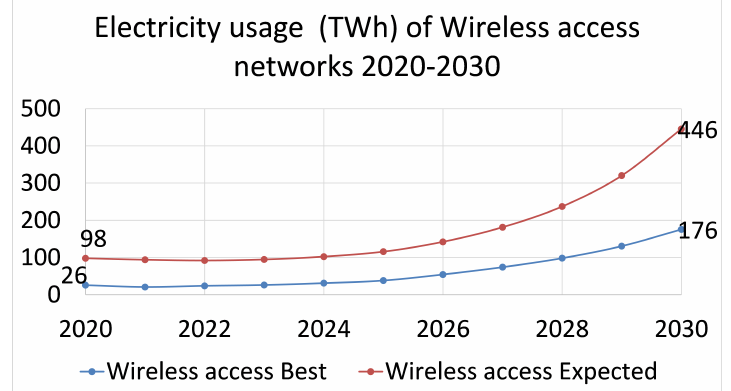
Figure 2. Trends for wireless access networks 2020 to 2030.